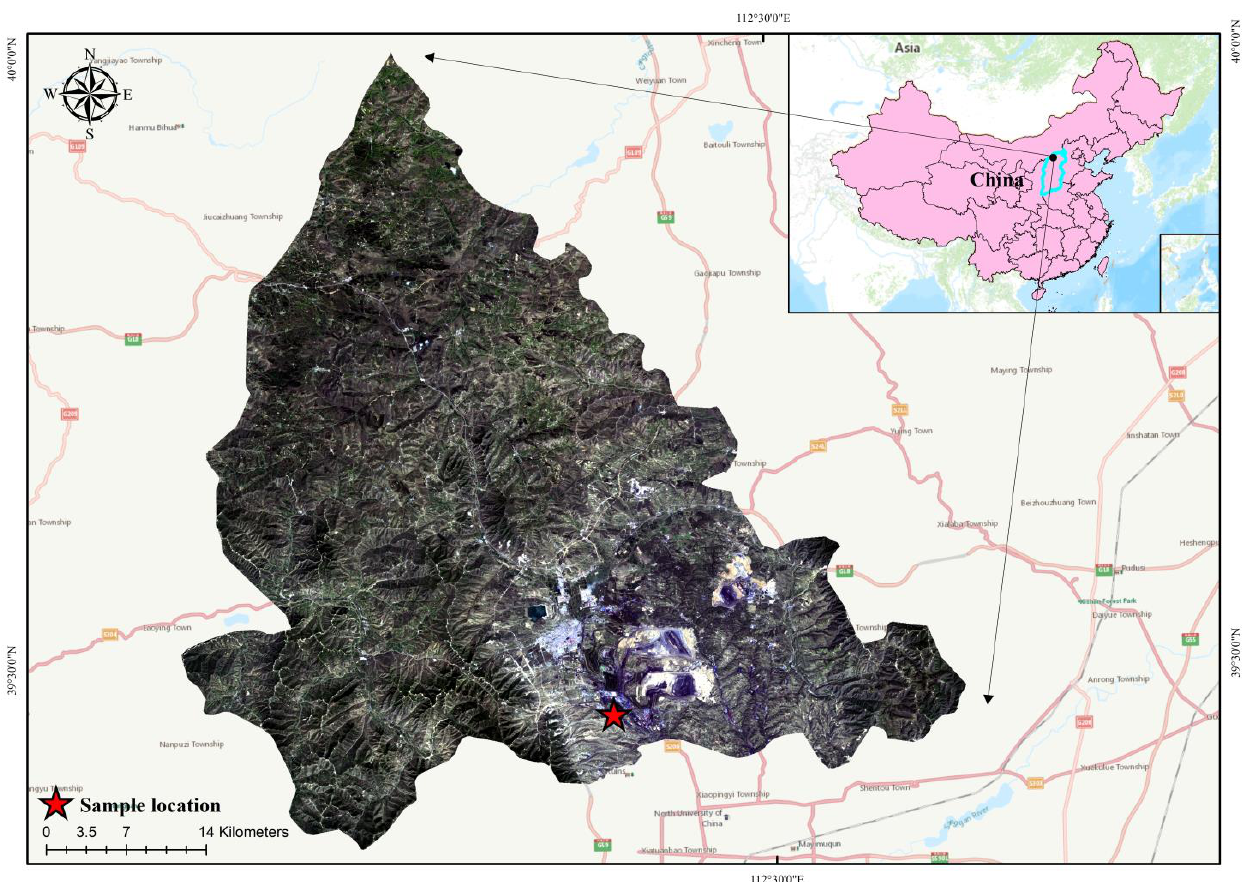
Figure 1. Geographical location of the study area.